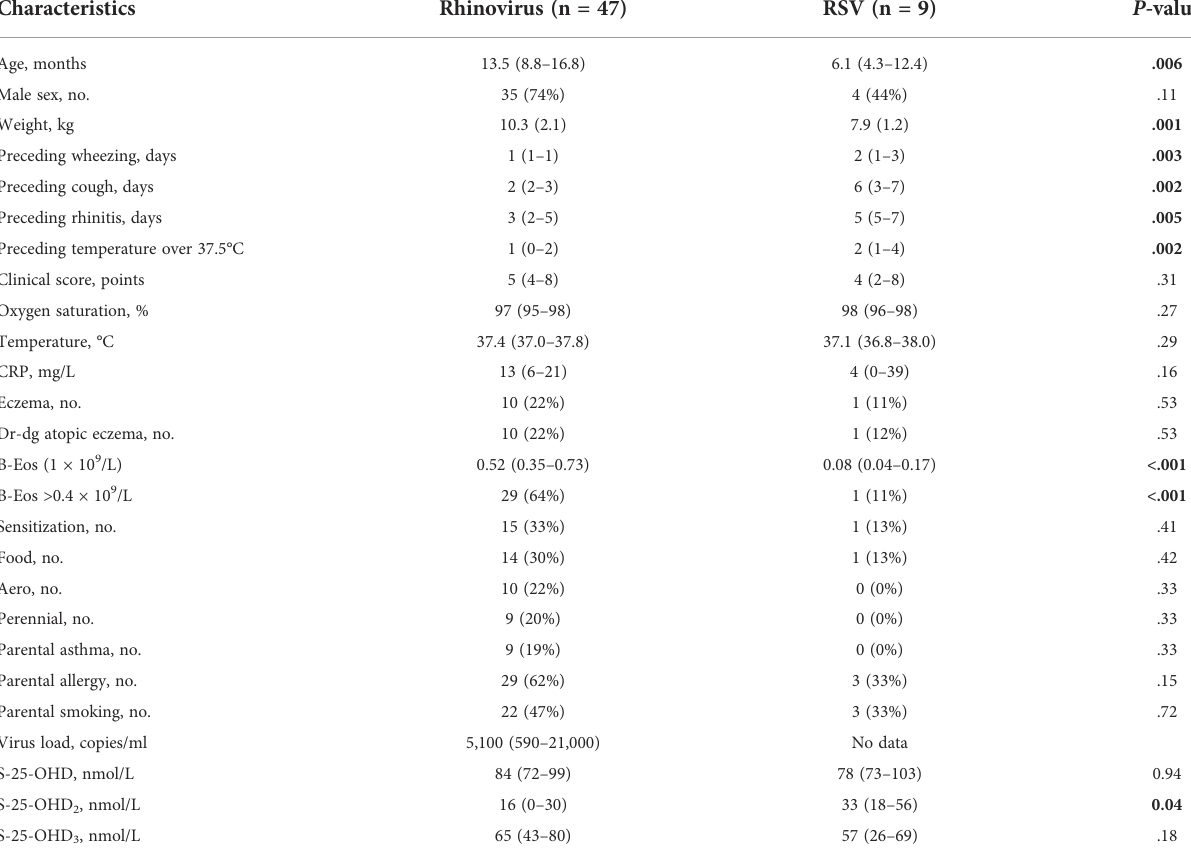
TABLE 1 Patient characteristics at study